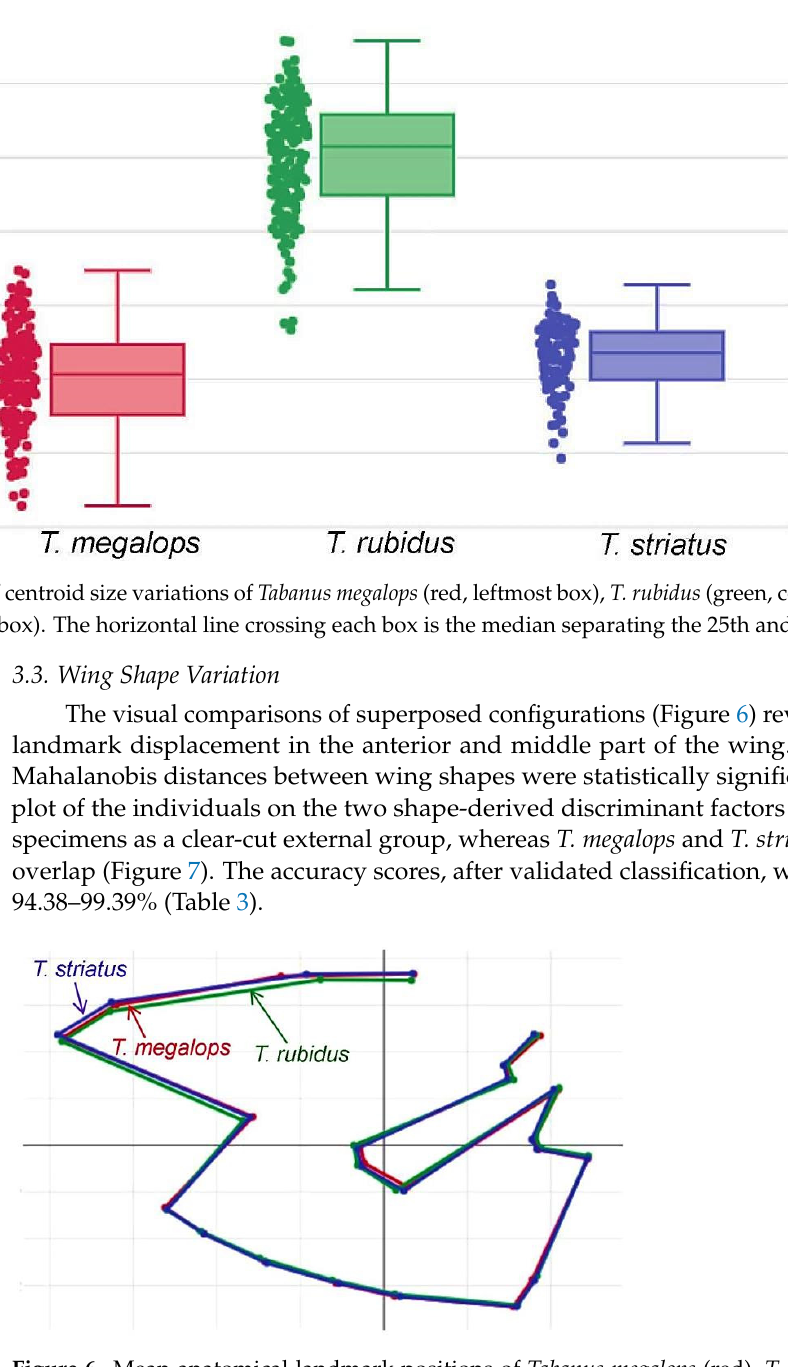
Figure 6. Mean anatomical landmark positions of Tabanus megalops (red), T. rubidus (green), and T. striatus (blue) after Procrustes superposition.